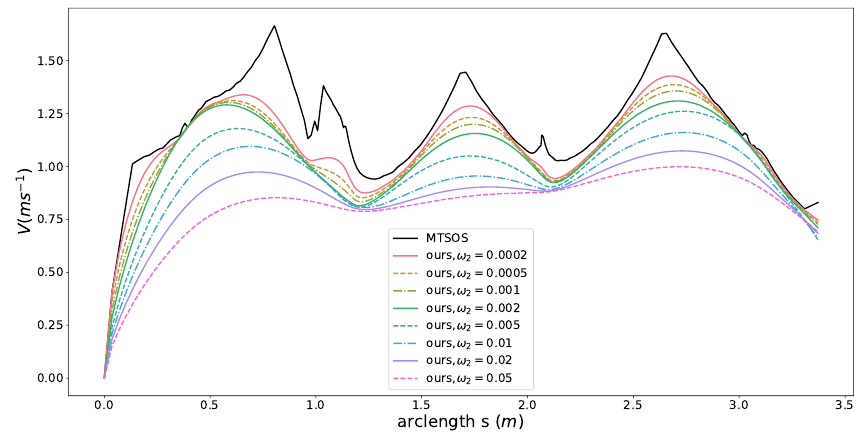
Figure 6. Speed planning results with different coefficients of the smoothness objective.